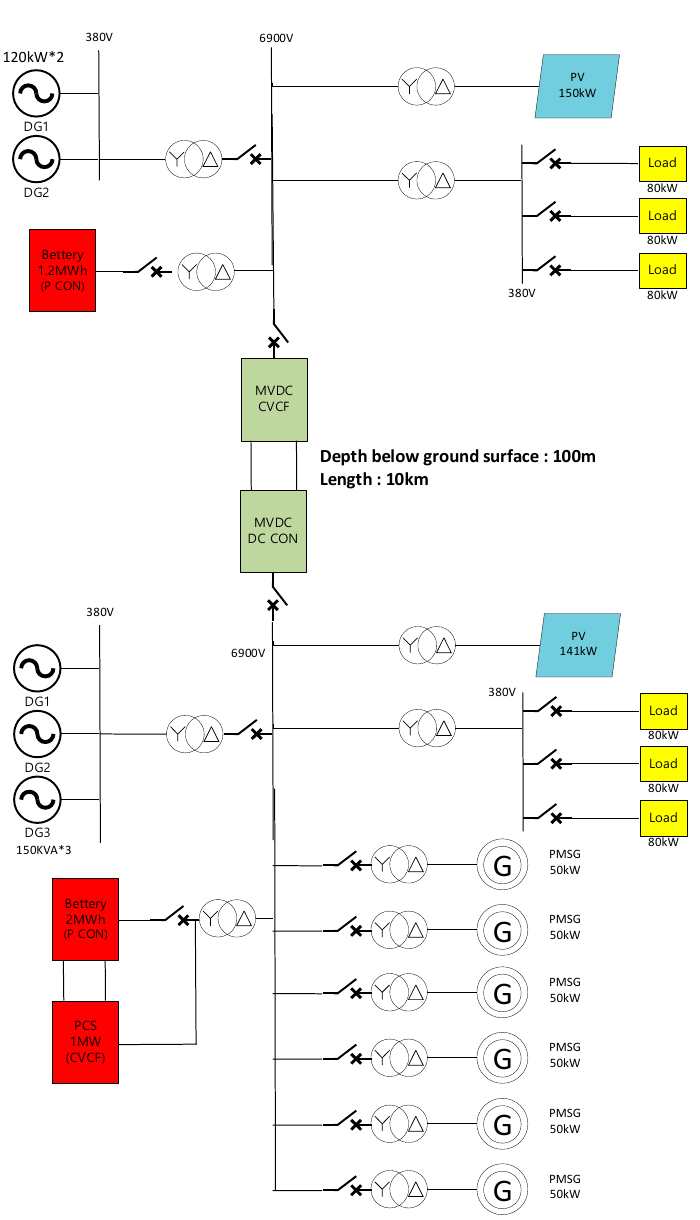
Figure 8. Microgrid composition of Gapado Island and Marado Island through MVDC Linkage .